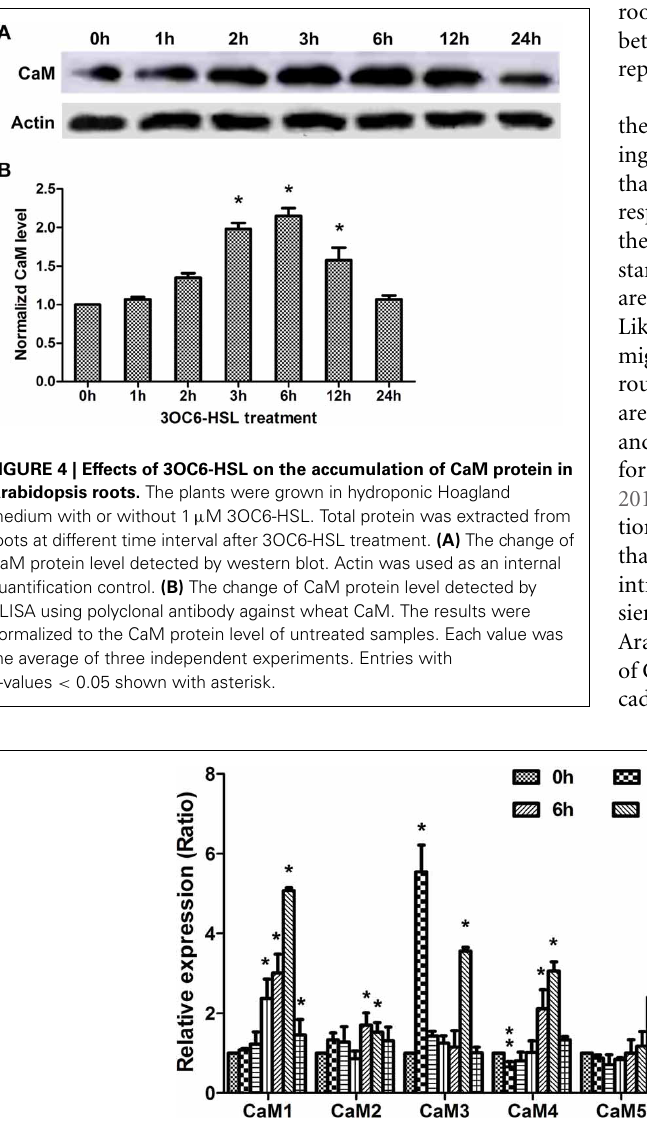
normalized to the 0h time point. Data represent the mean from three independent biological replications. Entries with p -values < 0.05 shown with asterisk. Relative expression of genes (ratio) > 1.5 was considered as up-regulation (single asterisk) and ratio < 0.8 was considered as down-regulation (double